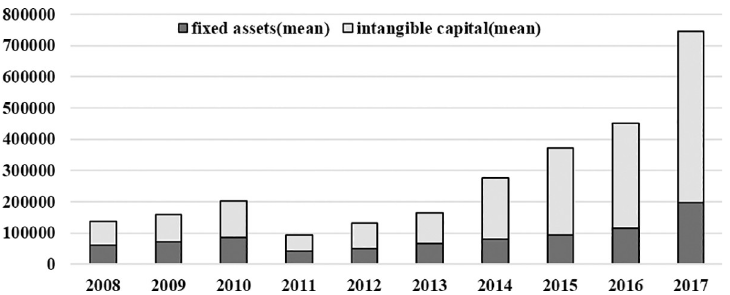
Fig 3. The trends of fixed assets and invisible capital investment of internet enterprises during